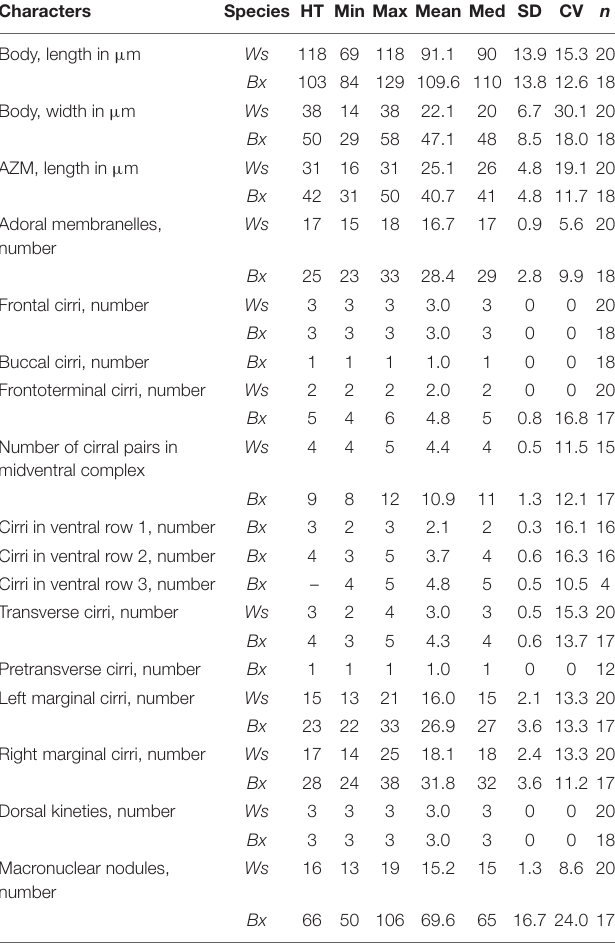
TABLE 1 | Morphometric data of Wilbertophrya sinica n. g., n. sp. ( Ws , upper line) and Bakuella xianensis n. sp. ( Bx , lower line).